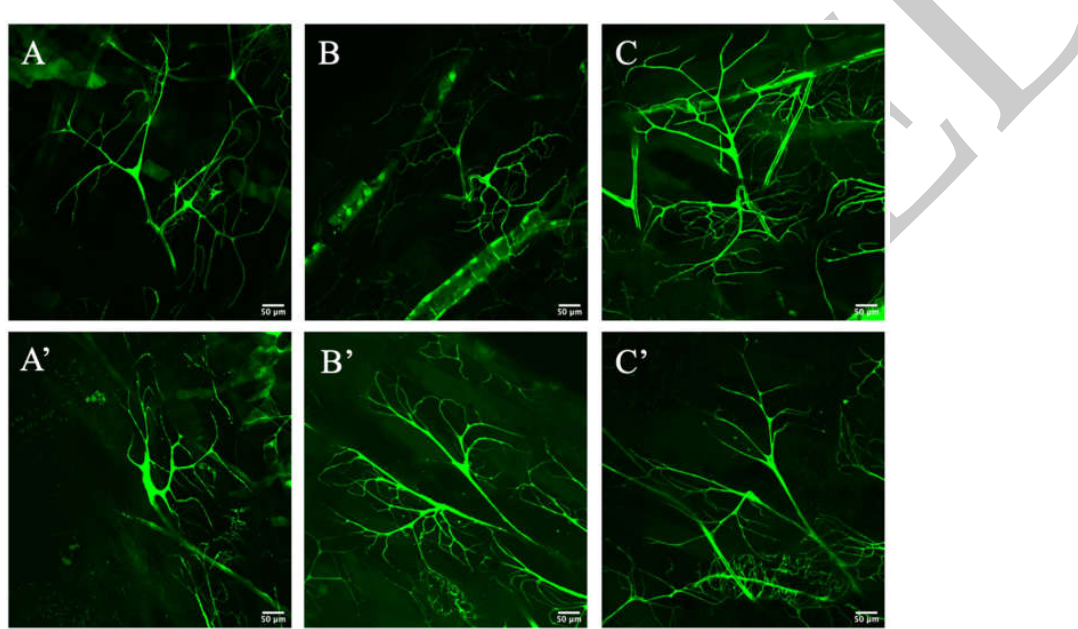
Figure 2. Branching morphogenesis of controls and mutants. ( A – C ) represent the terminal cells of heat-killed third instar larvae for the controls, while ( A’ – C’ ) represent the experimental terminal cells of heat-killed larvae. To justify that the experimental terminal cells were true knockdowns of Zipper, a